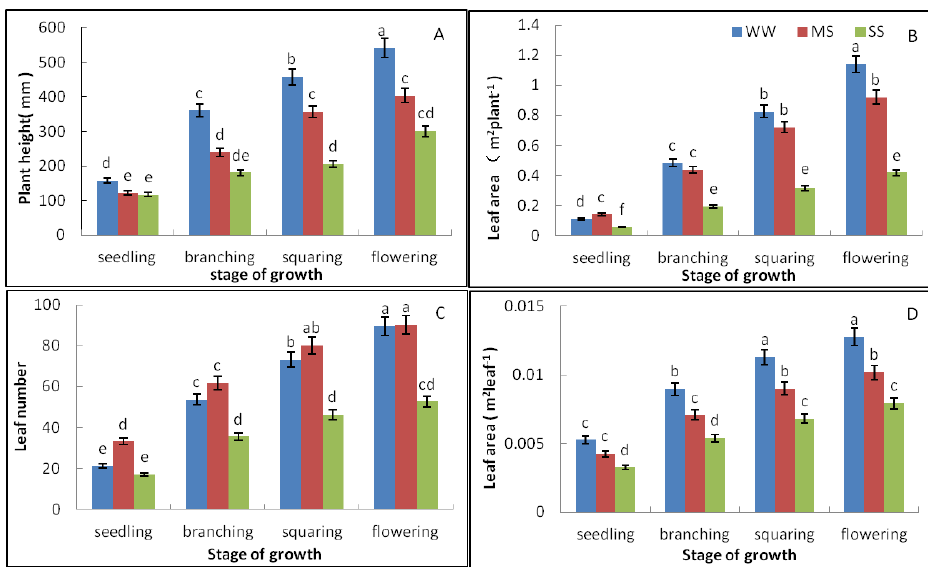
Figure 1. Effect of watering treatments (WW: water-sufficient (85% pot capacity (PC)), MS: moderate water stress (65% PC), and SS: severe water stress (45% PC)) on ( A ) plant height, ( B ) leaf area per plant, ( C ) leaf number per plant, and ( D ) leaf area per leaf at the four growth stages: seedling, branching, squaring, and flowering. The bars are ± one standard error of the mean ( n = 4). Different lower case letters represent significant differences at p < 0.05 according to Tukey ’s multiple range test ．